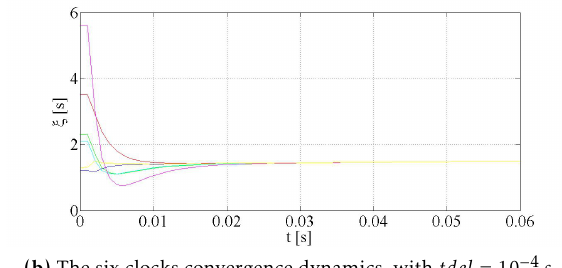
Figure 18. The clocks behavior of the six nodes with decentralized topology.